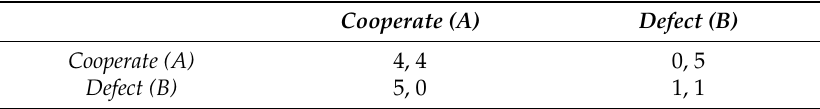
Table 1. The stage